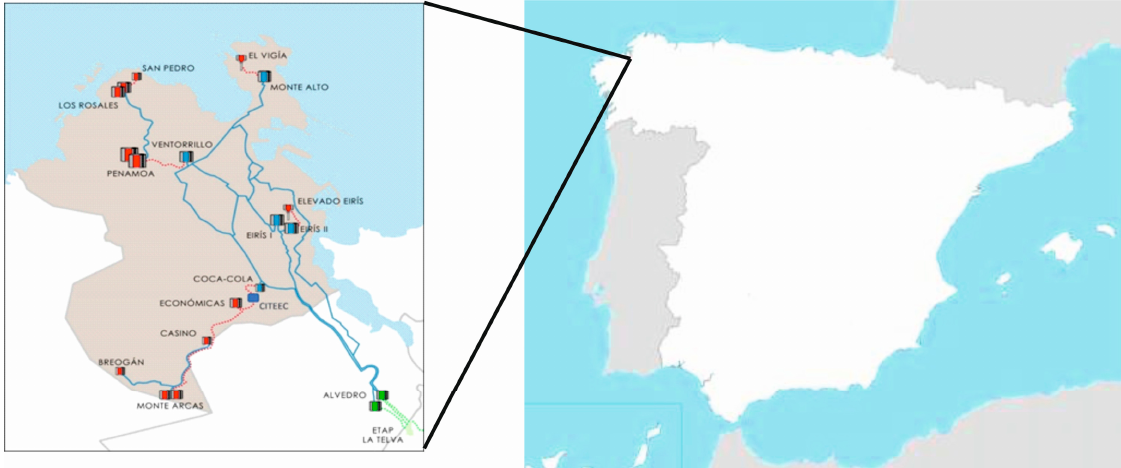
Figure 1. Simplified diagram of the pipeline distribution network from A Telva to La Coruña.